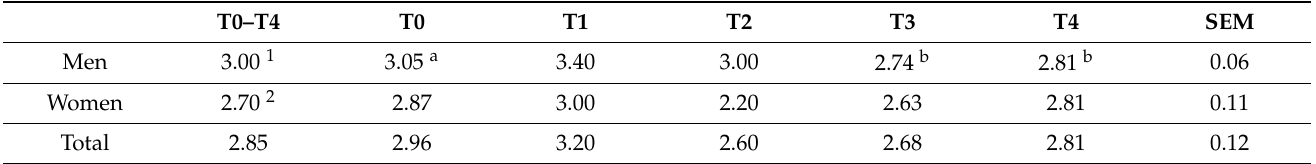
Table 7. Effect of tannin supplementation on sensory evaluation of tenderness.